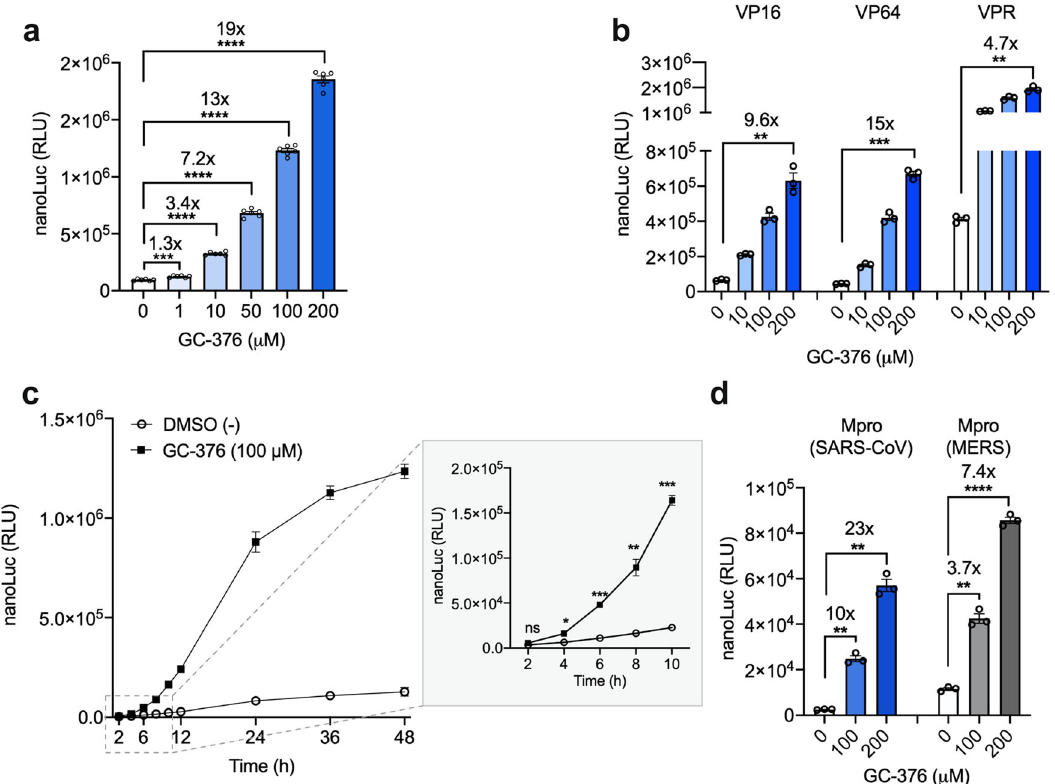
Fig. 3 Mpro-TAGS characterization. a Inducibility and sensitivity of the Mpro-TAGS in the presence of GC-376. Mpro-TAGS-transfected HEK293T cells (pNF151 and pNF167) were treated with different concentrations of the Mpro inhibitor GC-376 for 24 h before quantifying nanoLuc expression level. b Impact of different transactivation domains (VP16, VP64, and VPR) on Mpro-TAGS performance. HEK293T cells expressing a synTF bearing